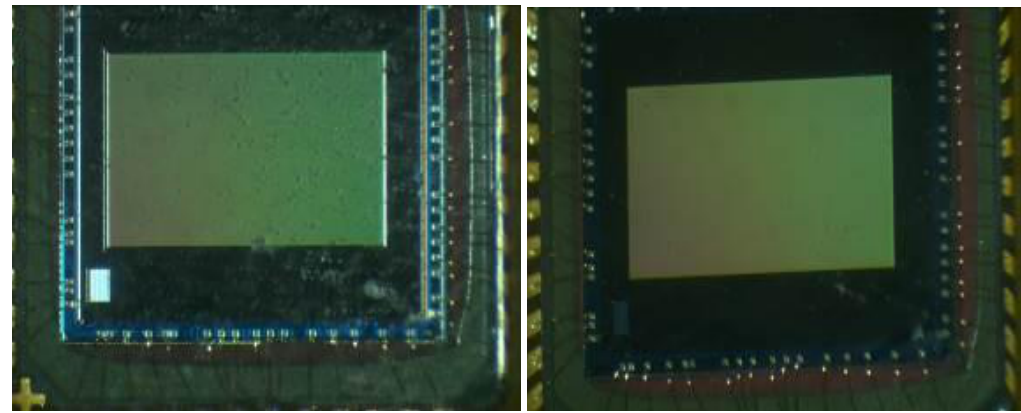
Figure 8. Comparison between the sensor before and after cleaning.